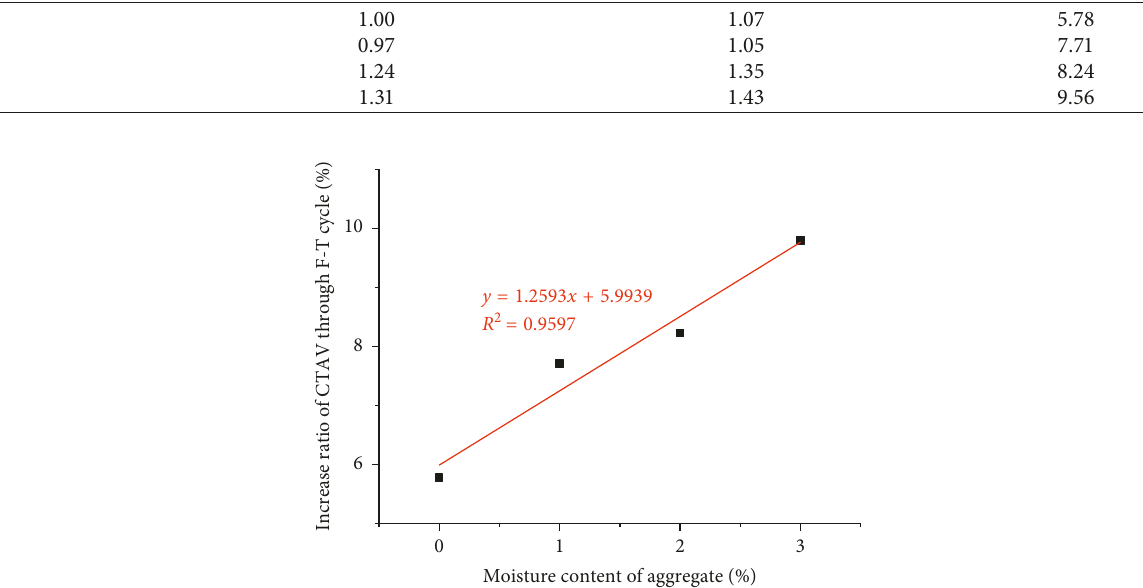
Figure 8: Moisture content in aggregates and increase ratio of CTAV through freeze-thaw cycles.